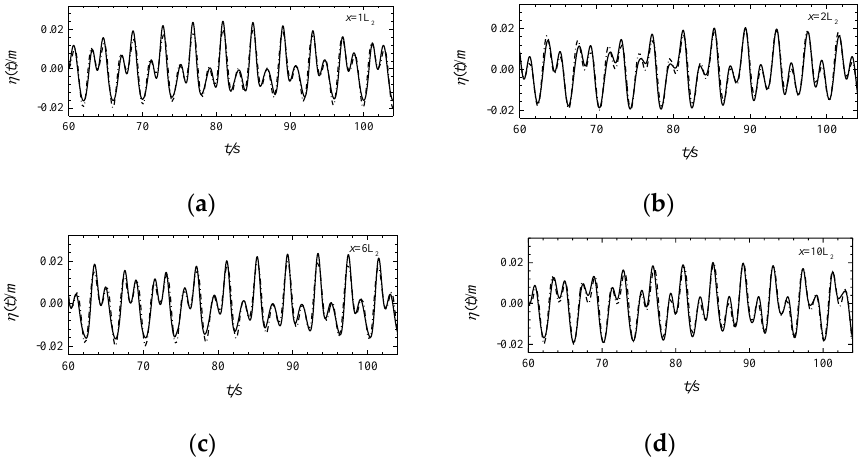
Figure 5. Comparison of the wavefront at x = 1L 2 ( a ), x = 2L 2 ( b ), x = 6L 2 ( c ), x = 10L 2 ( d ) of the MIKE 21 BW model (solid line) and the theoretical solution (dashed line) (operating condition C2).